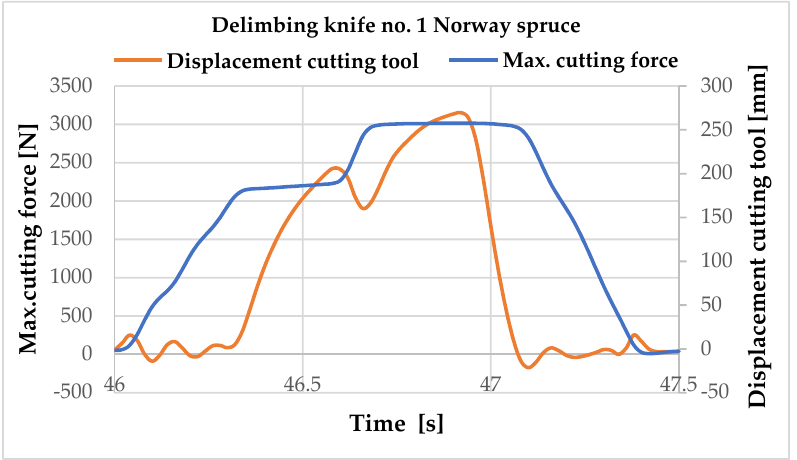
Figure 6. The course of experimental measurement of delimbing—delimbing knife No.1.